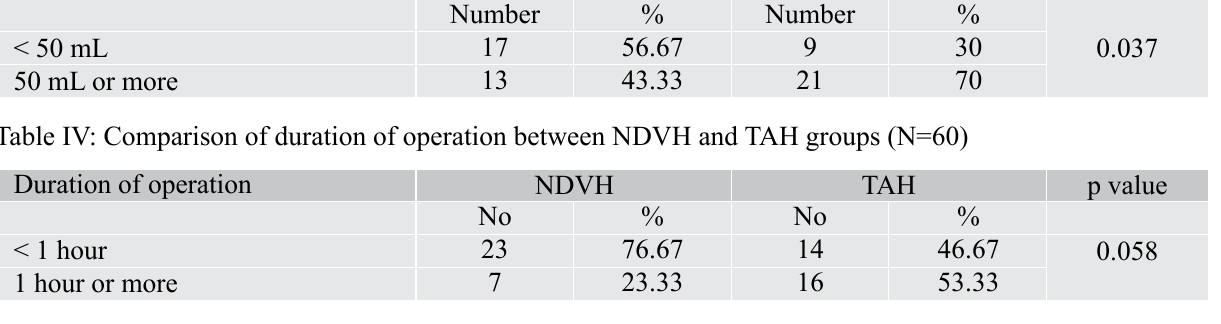
Table V: Comparison of pattern of complications between NDVH and TAH groups (N=60) Complications UTI Febrile illness Wound infection